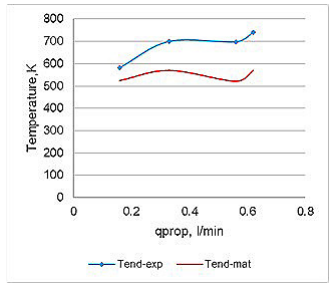
Figure 33. Concentration of species CO in experiment [ g/m 3 ] at the inlet and calculated mass fraction C1end at the outlet depends on propane injection qprop [l/min].